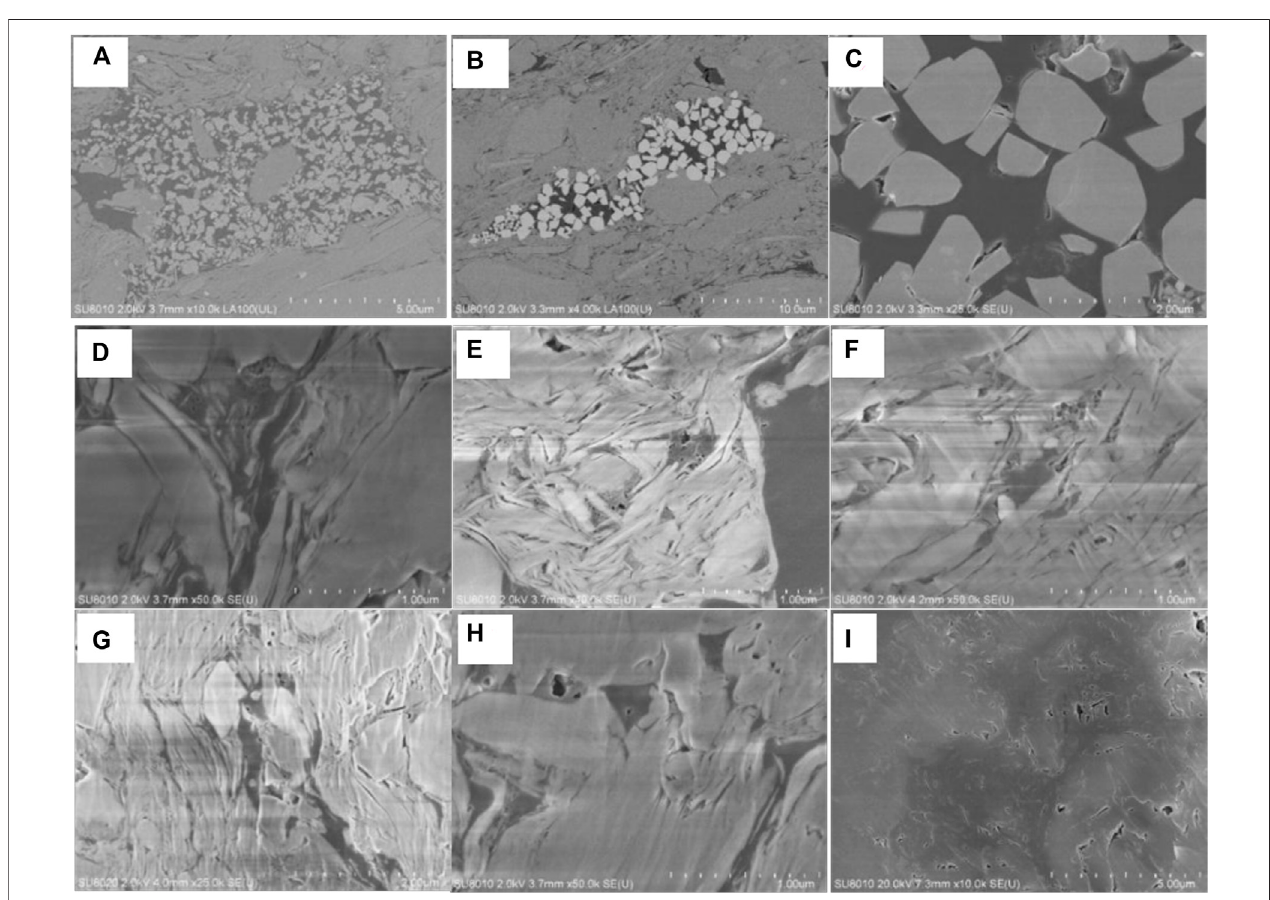
FIGURE3| FieldemissionSEM characteristics oforganic matter (A) FE-SEMimage showing pyrite and organic pores in organic matter, Q71well, 1428.84 m; (B) FE-SEM image showing strawberry pyrite in organic matter, Q129 well, 1661.18 m; (C) FE-SEM image showing pyrite and organic pores in organic matter, Q129 well, 1661.18 m; (D) FE-SEM image showing organic matter with organic pores in clay minerals, Q71 well, 1428.84 m; (E) FE-SEM image showing organic matter with organic pores in clay minerals, Q71 well, 1428.84 m; (F) FE-SEM image showing organic matter with organic pores in clay minerals, Q71 well, 1427.94 m; (G) FE- SEMimageshowingorganicmatterinbetweenclaymineralsandbrittleminerals,withhighlydevelopedintergranularpores,intragranularporesandorganicpores,D199 well,1372.59 m; (H) FE-SEMimageshowingorganic matter inbetween clayminerals and brittleminerals, with highly developed intergranular pores, intragranularpores and organic pores, Q71 well, 1428.84 m; (I) FE-SEM image showing organic matter in between clay minerals and brittle minerals, with highly developed intergranular pores, intragranular pores and organic pores, W104 well, 1363.96 m.